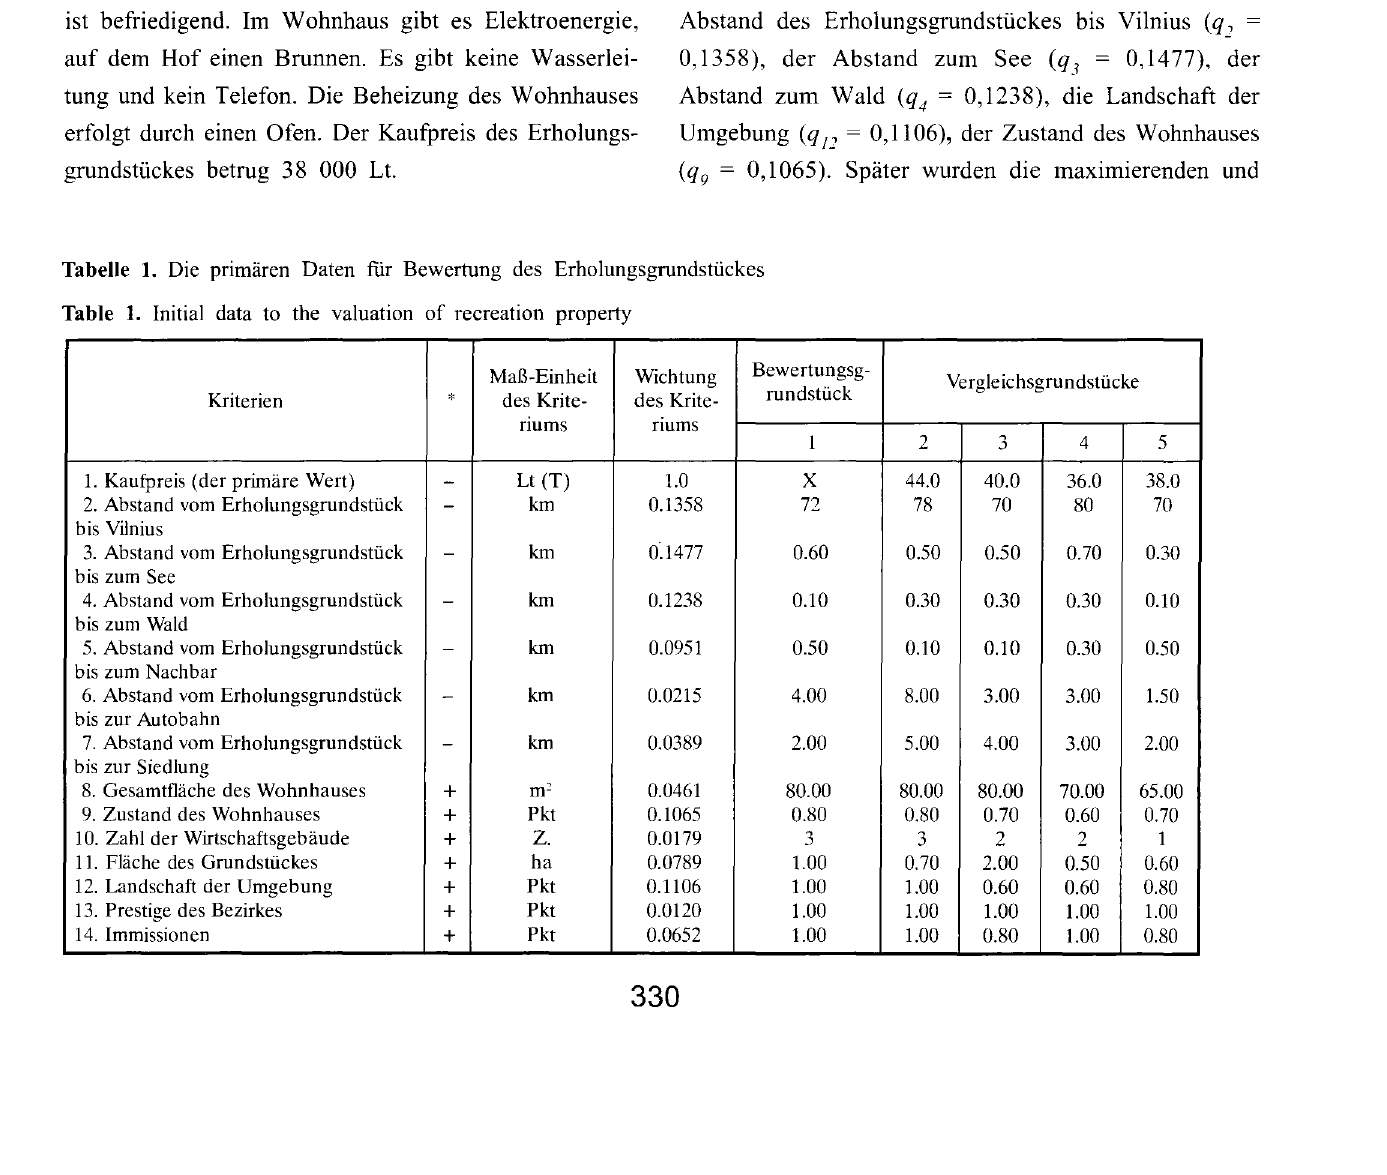
Table 1. Initial data to the valuation of recreation property MaB-Einheit Wichtung Bewertungsg- Vergleichsgrundstiicke Kriterien * des Krite- des Krite- rundstiick